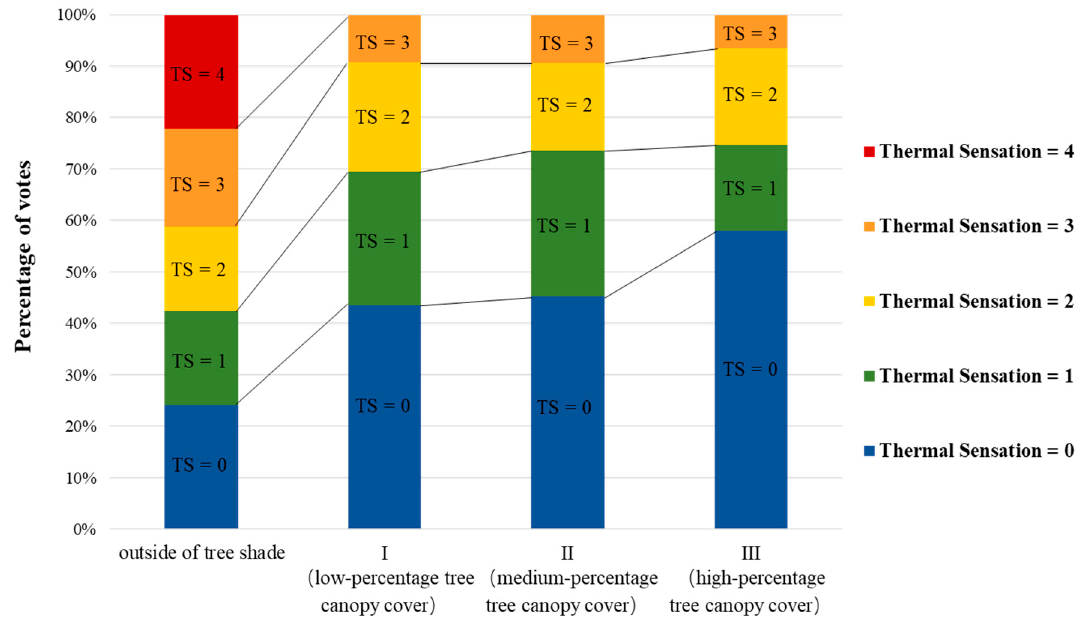
ff erent degrees of tree canopy